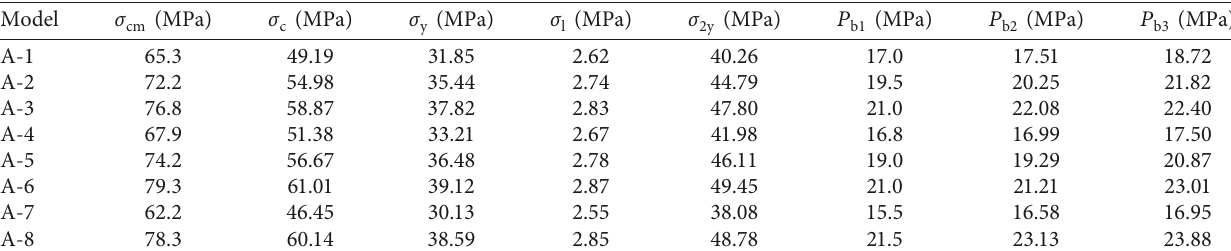
Table 9: Comparison of theoretically, experimentally, and numerically determined HSHPRCSL plastic ultimate bearing capacity. Model